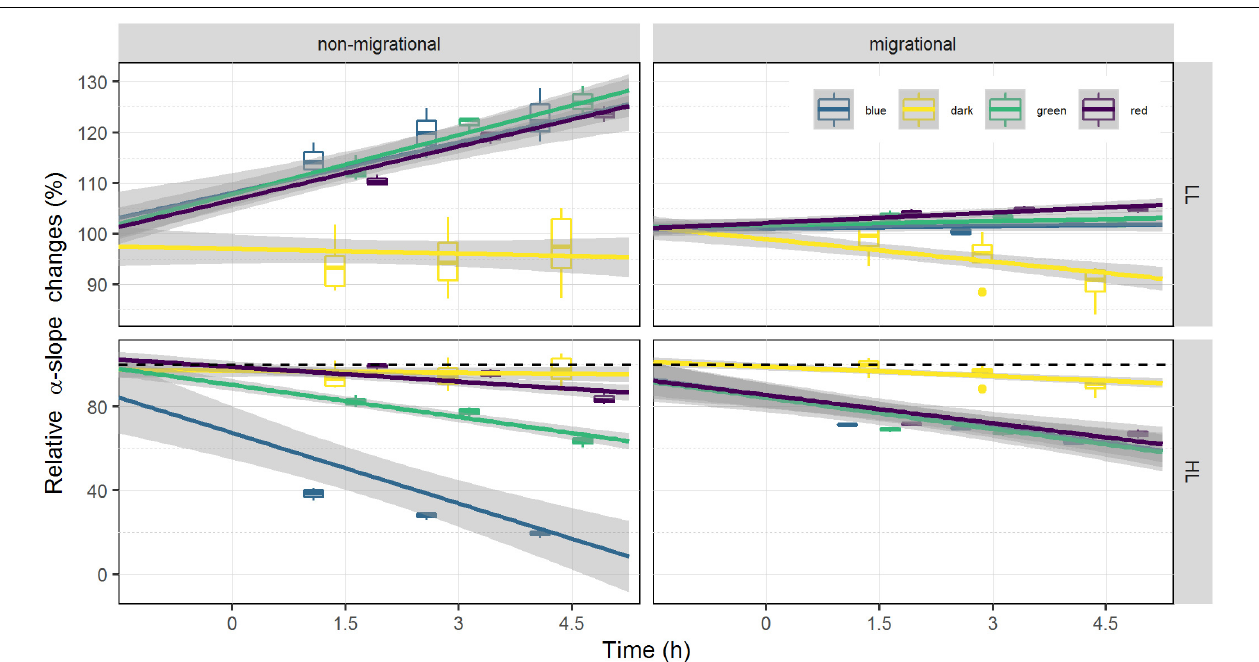
FIGURE 6 | Relative changes of α -slope. α -slope is displayed as percentage of the initial value prior to illumination (at T0). α -slope variations is used as a proxy of NPQ as it is inversely proportional. Each color has been fitted with a linear model where confidence interval (0.95) are represented in gray ( n = 3).